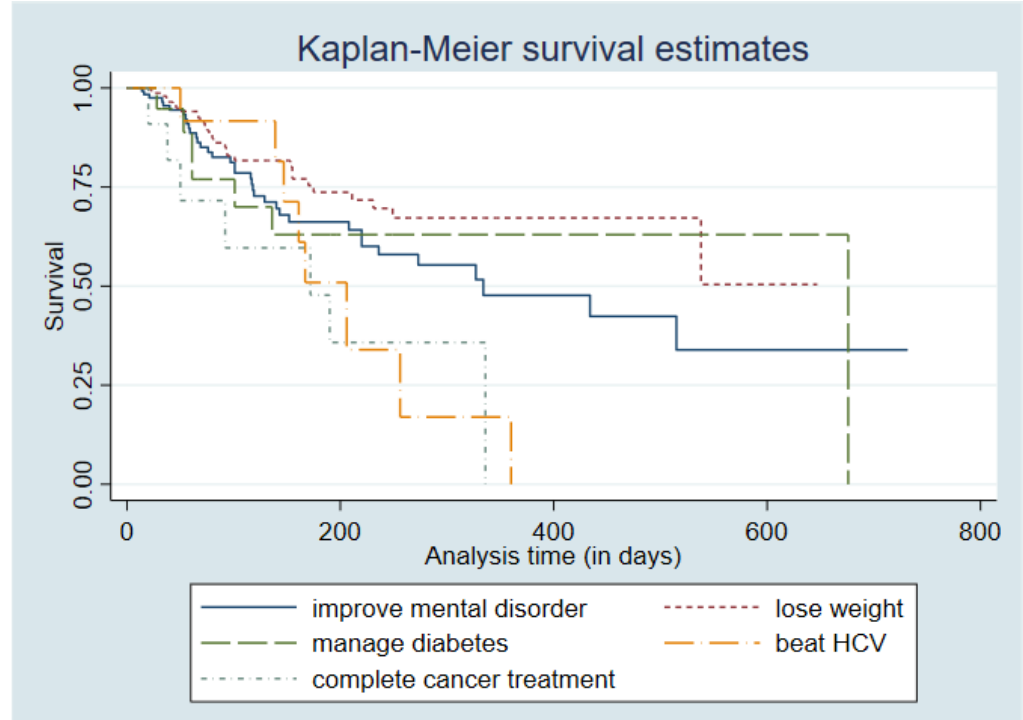
Figure 3. Kaplan-Meier survival estimates by goal types. HCV: hepatitis C